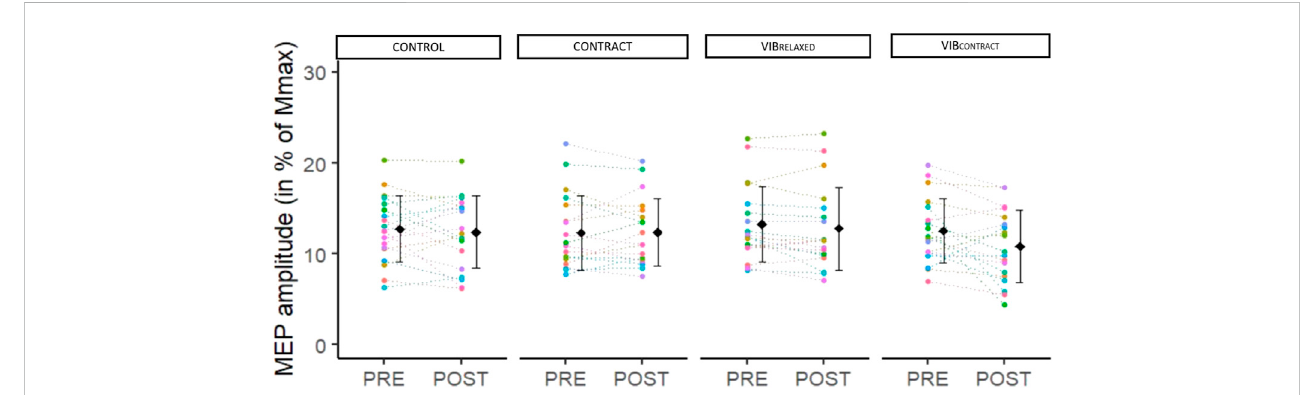
FIGURE 4 Meanandindividual MEPamplitudesin%ofMmax.PRE,POSTandPOST30valuesarerepresentedfor eachcondition. Eachdotrepresentsthevalueofa